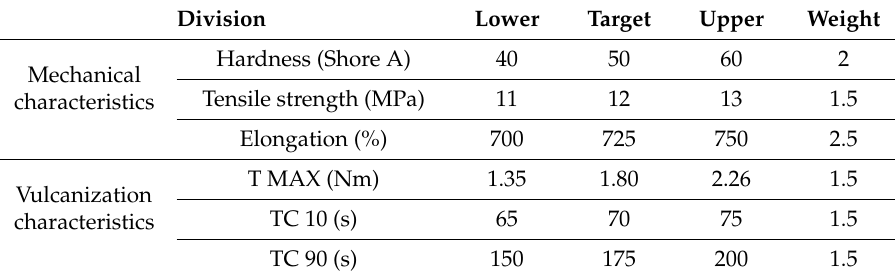
Table 2. List of parameters for optimization experiments.